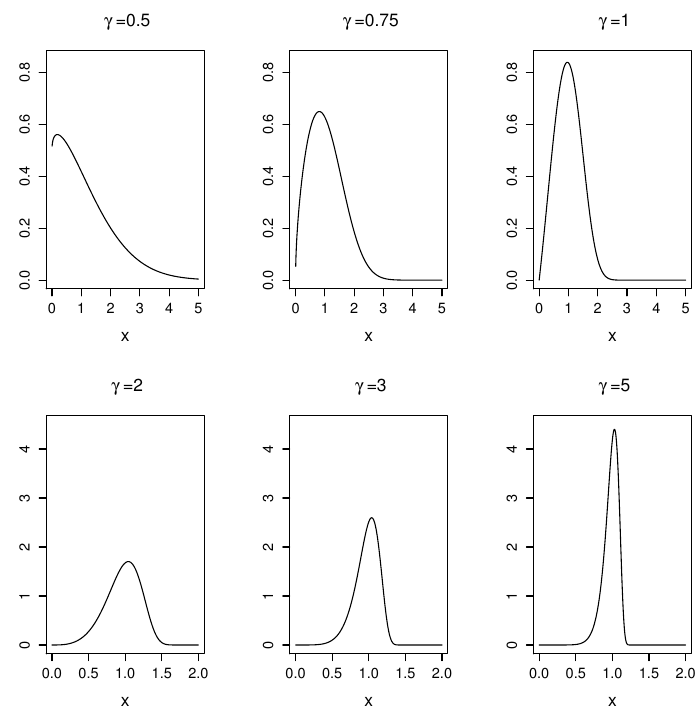
Figure 1. Pdf of the PM( β,γ ) distribution for β = 1 and different values of γ .